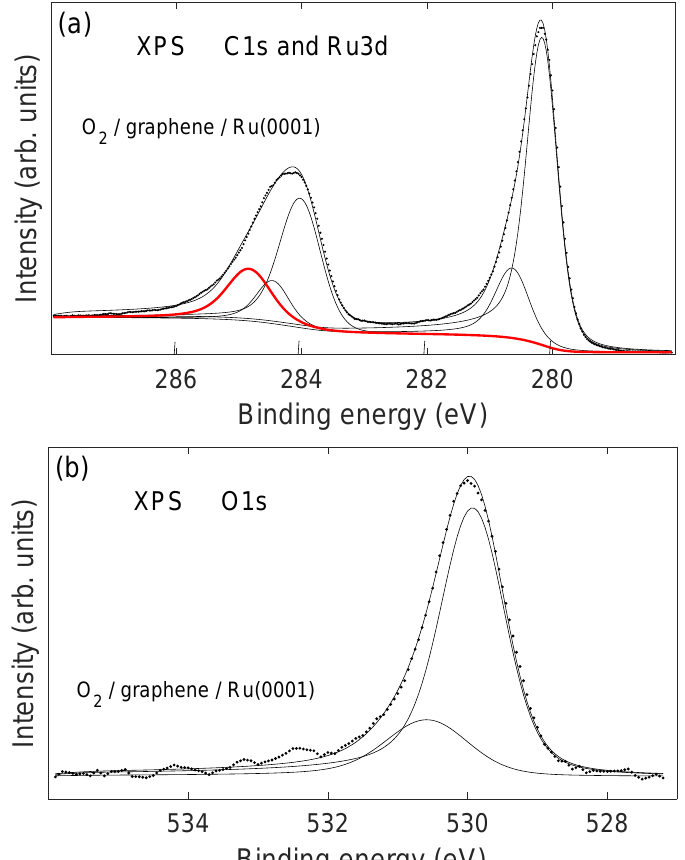
Figure 4. XPS from a saturated graphene layer on Ru(0001) that was exposed to 200 L of oxygen gas at temperature 675 K. ( a ): C1s and Ru3d core levels. The leftmost peak (thick red line) is the C1s emission. ( b ): O1s core level. Solid lines show deconvoluted spectra. The electron exit angle was about 70 ◦ with respect to the surface